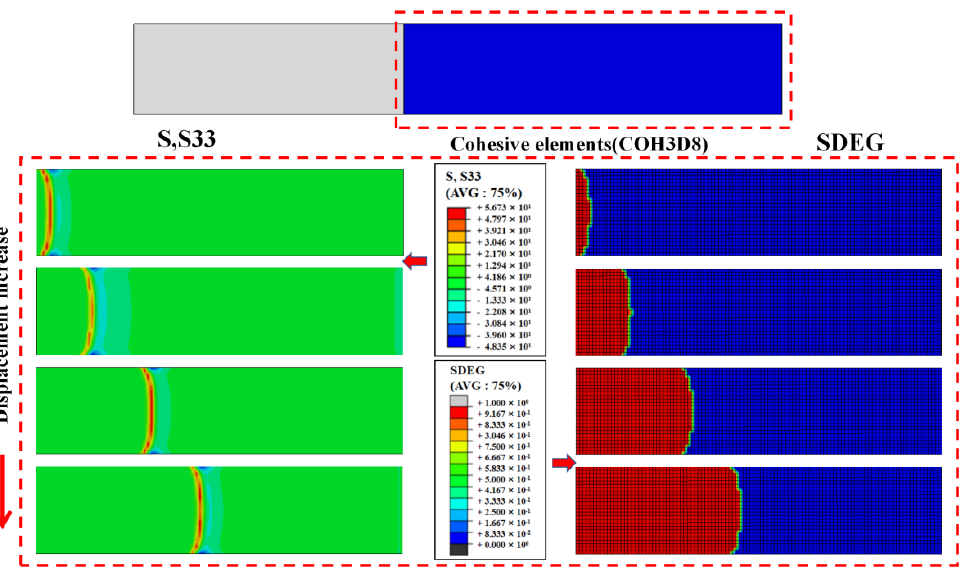
Figure 10. Peel stress distribution and interlaminar damage associated with the load displacement increasing for the original specimens.